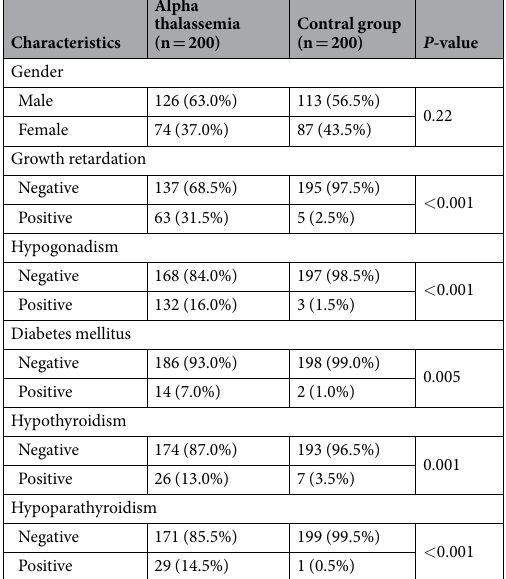
Characteristics